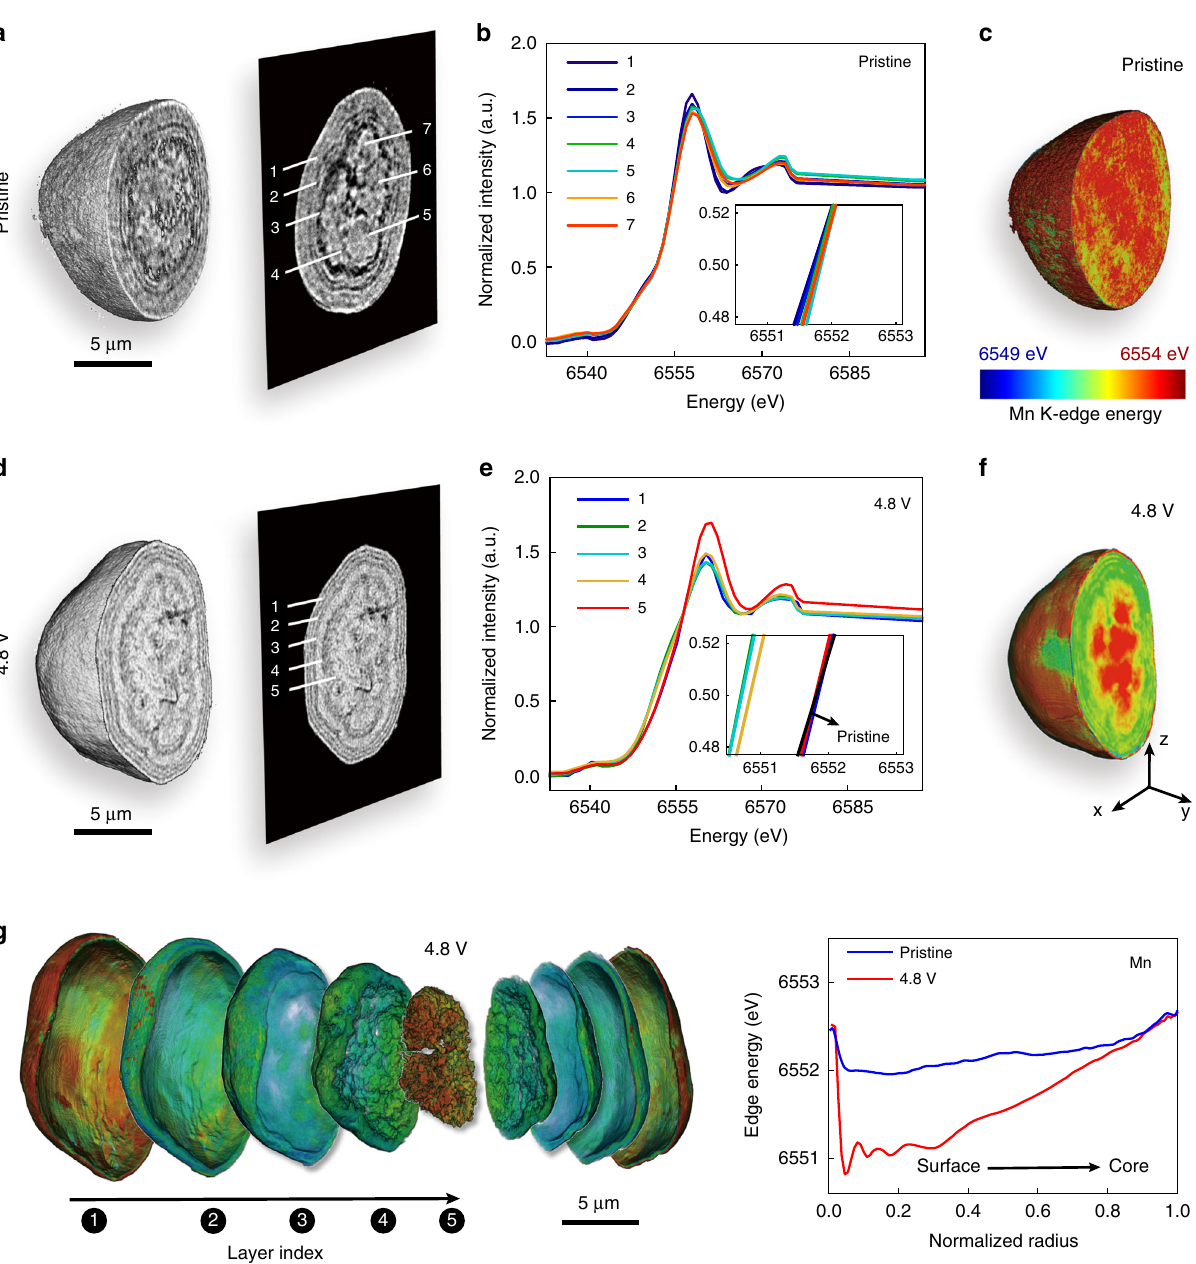
Fig. 2 Spectro-microscopic investigation of the LirNMC particles. Panels ( a ) to ( c ) are on a pristine particle and panels ( d ) to ( g ) are on a charged particle (at 4.8 V in the fi rst charge). Panels ( a ) and ( d ) are the 3D visualizations of the pristine and charged particles, with the labeling of different regions of interest on the respective central xz -slices. Panels ( b ) and ( e ) are the Mn K-edge x-ray absorption spectroscopic fi ngerprints over the regions of interest shown in panels ( a ) and ( c ), respectively. Panel ( c ) and ( f ) are the 3D renderings of the Mn ’ s valence state distribution in the pristine and the charged particles. Panel ( g ) is a detailed layer-by-layer rendering of the Mn ’ s valence state in the charged particle. Panel ( h ) is the comparison of the depth pro fi les of the particles in panels ( c ) and ( f